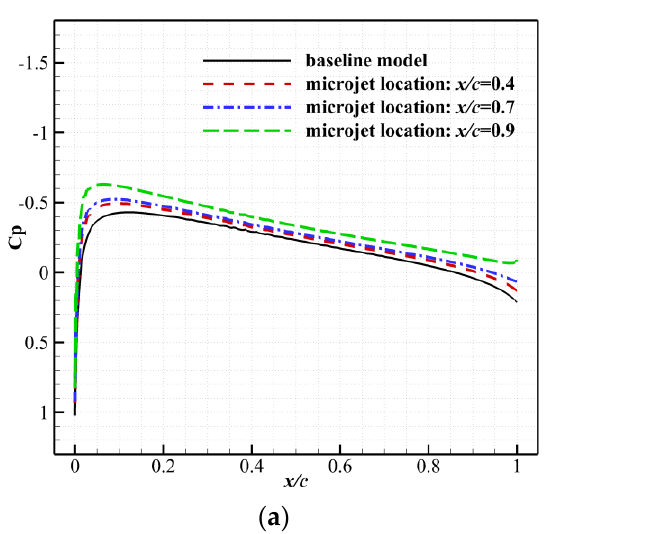
Figure 3. Influence of Microjet location on lift coefficient reduction with M jet = M ∞ = 0.3 (from [30]).